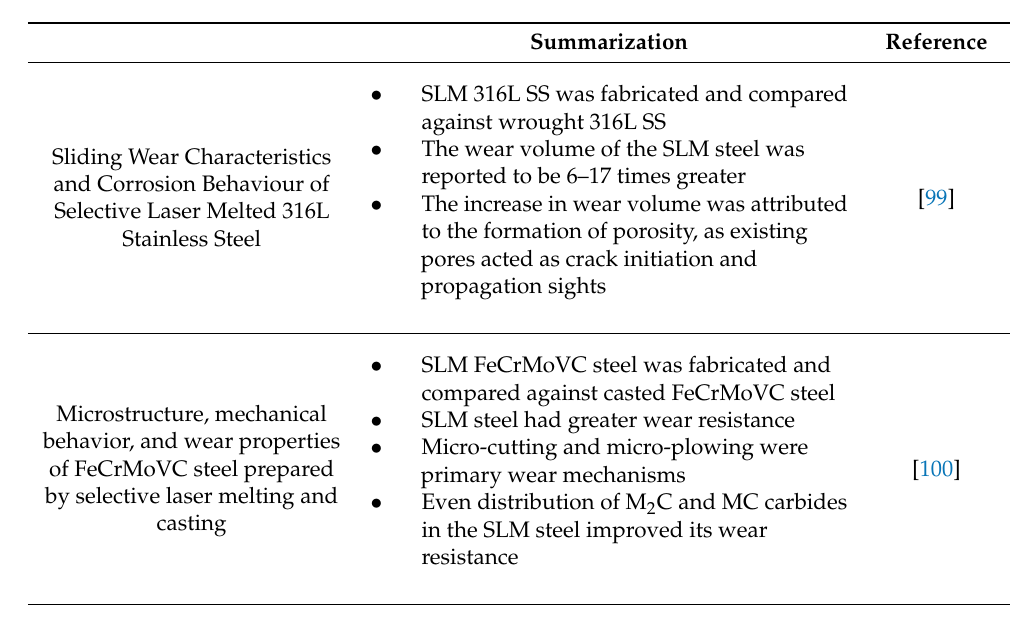
Figure 10. The ( a ) average COF, ( b ) COF over a sliding distance, and ( c ) wear rates of SLM 316L SS under different post-processing conditions. The worn surface morphology of the ( d ) conventional rolled 316L SS, ( e ) SLM 316L SS at 120 W and 100 mm/s scanning speed, ( f ) SLM’ed 316L SS at 120 W and 280 mm/s scanning speed, and the ( g ) EDS scan of the red box in portion [102]. Table 3. Various publications summarize SLMs effects on the tribological properties of SLM- manufactured